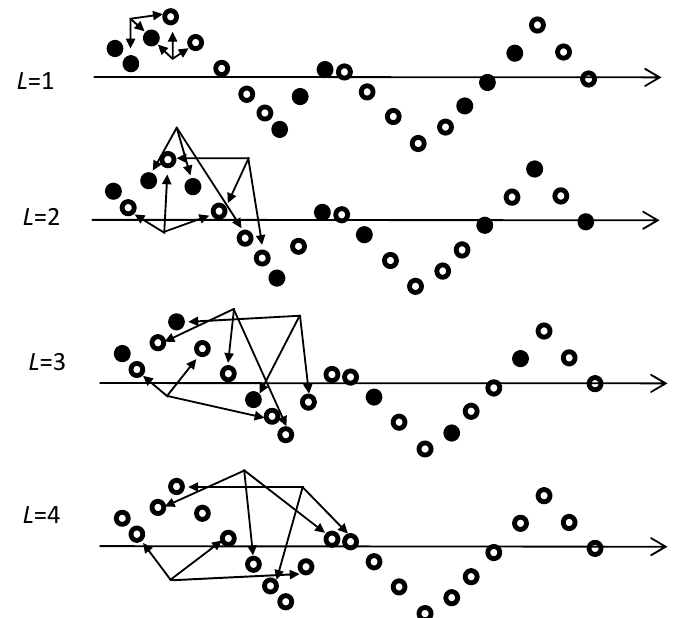
Fig. 1: Signal patterns for different values of time delay (Avilov and Popov, 2014)